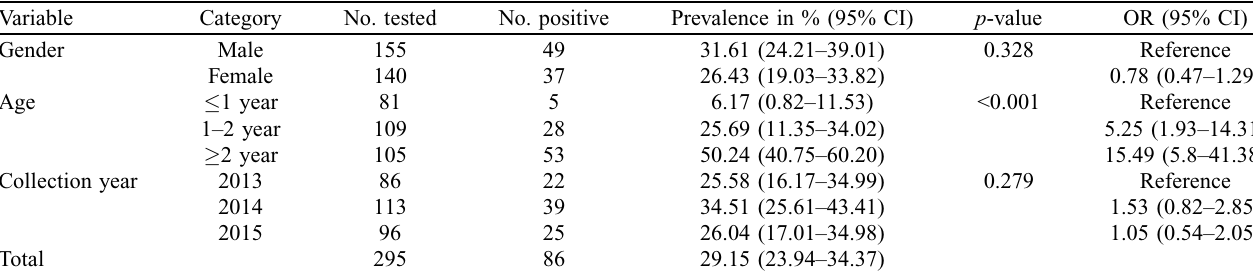
Table 1. Seroprevalence of Toxoplasma gondii in roe deer by gender, age, and collection year.